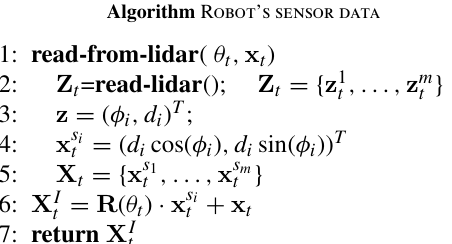
Table 1 Algorithm Robot’s sensor data